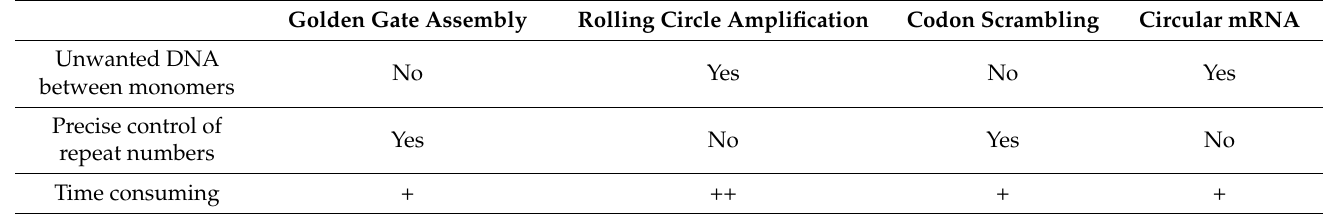
Table 1. Comparison between different methods for assembling repetitive DNAs. “+” and “++” symbols indicate the respective levels of time commitments.